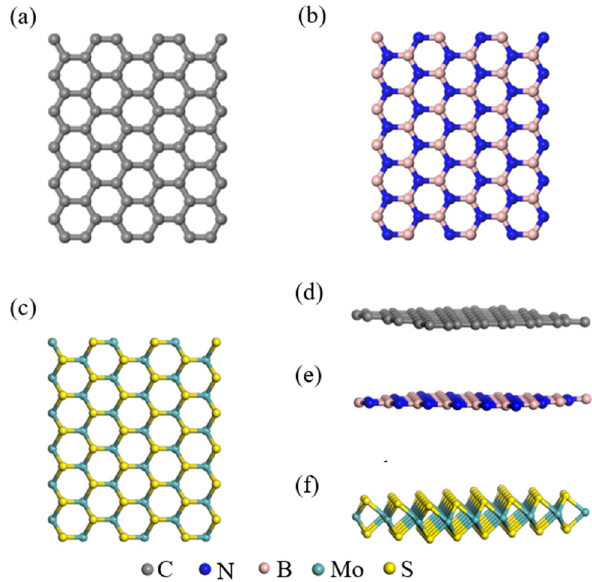
Figure 5: The in - plane structures of ( a ) graphene, ( b ) BNNS, and ( c ) MoS 2 nanosheet, and the lateral structure of ( d ) graphene, ( e ) BNNS, and ( f ) MoS 2